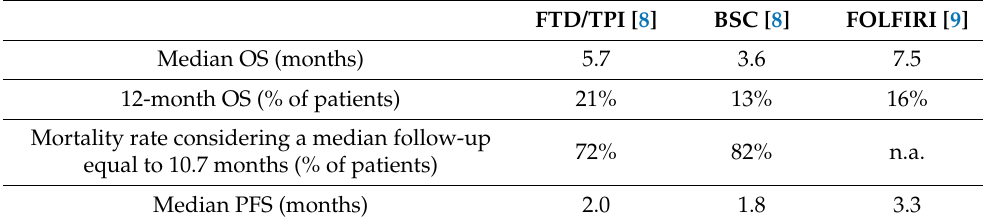
Table 2. Efficacy